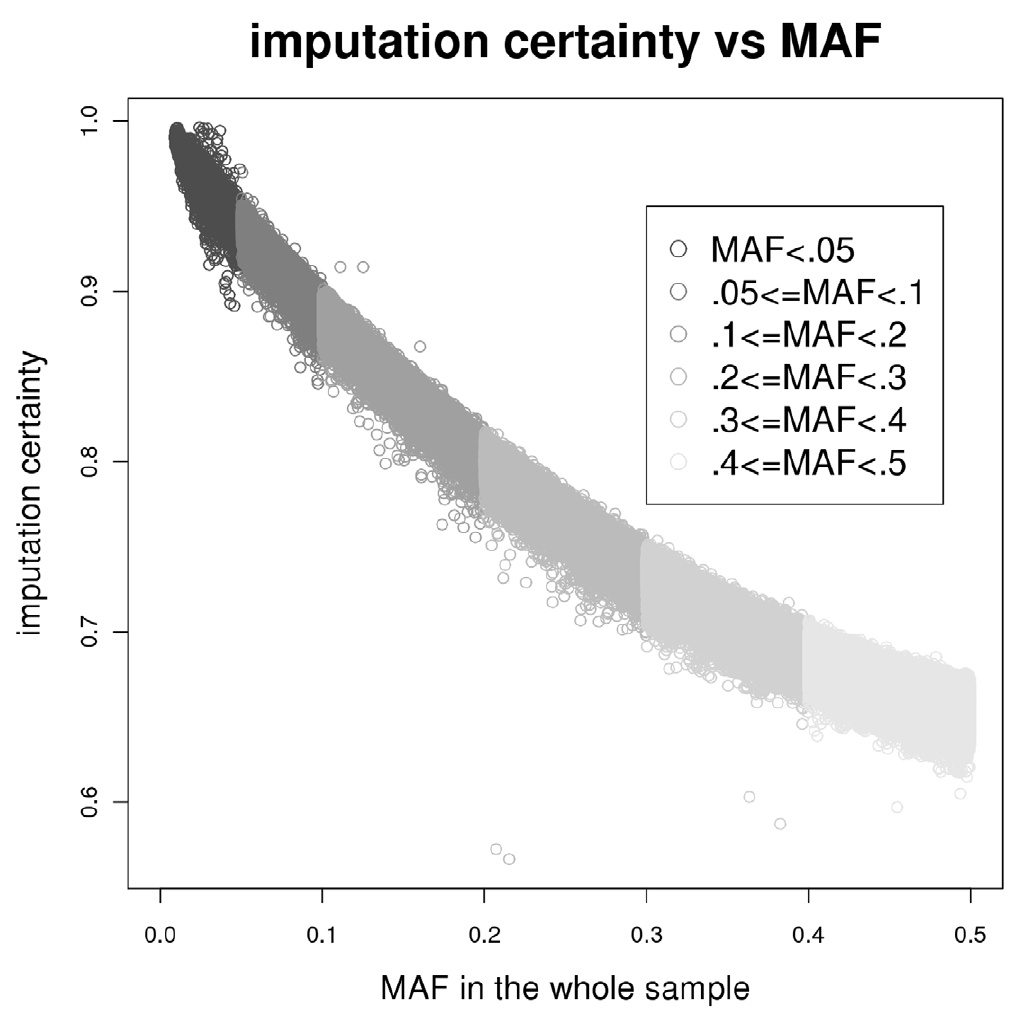
Figure 2. Scatter plot of imputation certainty against MAF.